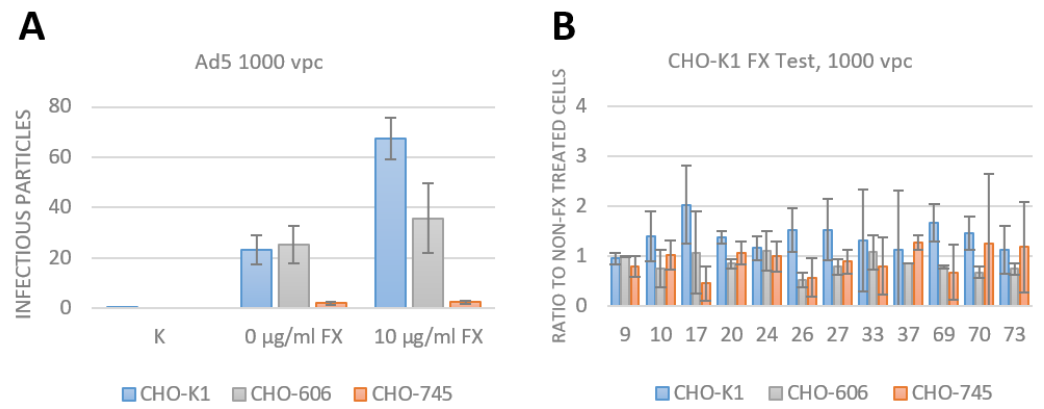
Figure 6. Early uptake of adenovirus 5 as control and 13 species D adenovirus into CHO cells. The cells were infected with 1000 vpc of each virus with or without 10 µg/mL FX. At 3 hpi, gDNA was isolated and duplex qPCR detecting GAPDH as housekeeping gene and neomycin contained in the Ad genome was performed. The infectious particles in the different cell lines are displayed in blue (CHO-K1 cells), grey (CHO-606 cells) and orange (CHO-745 cells). ( A ). As proof of concept, the CHO cells were infected with 1000 vpc of adenovirus 5 with and without FX. The early uptake of viral particles was 3-fold higher with FX than without in CHO-K1 cells. The number of infectious particles stayed the same in CHO-606 cells with and without FX, and in the CHO-745 cells with no heparan chains, the uptake of particles was very low under both conditions. N = 2 biological replicates. ( B ). The CHO cell lines were infected with 1000 vpc of each species D adenovirus. After 3 hpi no effect of FX was seen either in wild type HSPG CHO cells or in the HSPG depleted cells. Mean ± SEM of n = 3 biological replicates is